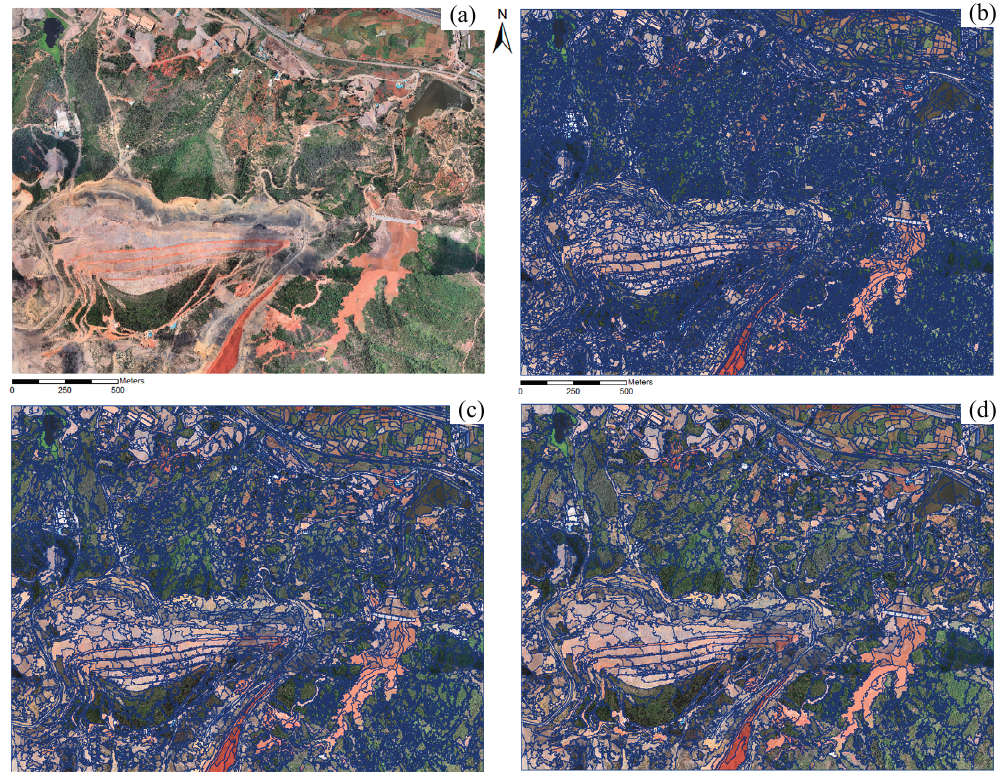
Figure 6. Comparison of image segmentation at the different levels used in the object-based classification. ( a ) UAV mosaic image from Jianshan; ( b ) Image segmentation with a MRS scale of 200; ( c ) Image segmentation with a MRS scale of 400; ( d ) Image segmentation with a MRS scale of